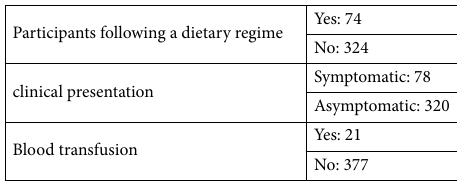
Table 3. Dietary regime, clinical presentation and receiving blood transfusion among the participants.